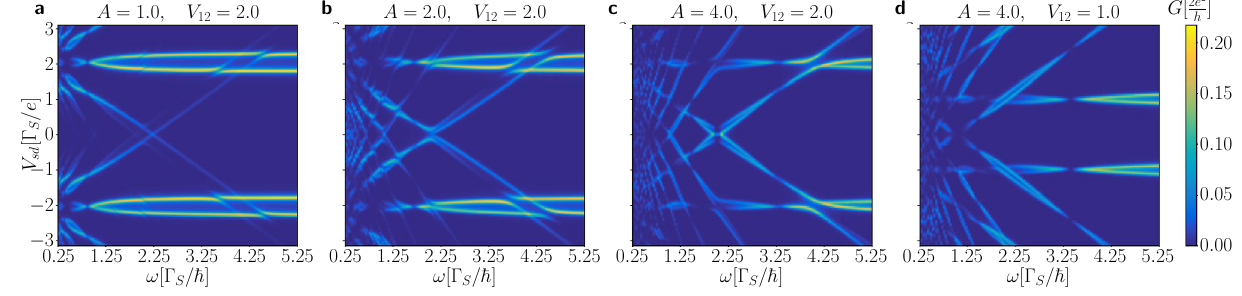
Figure 8. Frequency dependent conductance. The averaged Andreev conductance G N σ ( V sd ) in units of 2 e as a function of the frequency ω and source-drain voltage V sd obtained for several amplitudes A and interdot couplings V 12 (in units of Ŵ S ), as indicated. We used the model parameters U